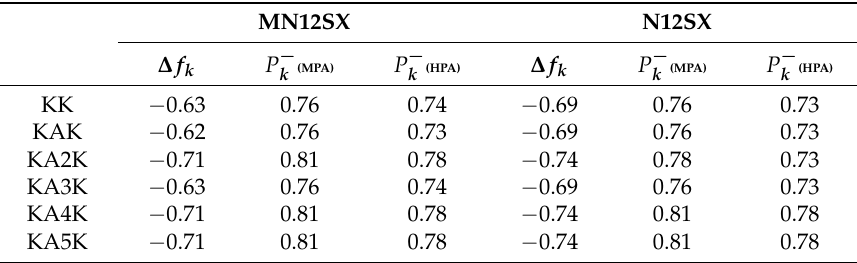
Table 2. Condensed dual descriptors and electrophilic Parr functions P − KA3K, KA4K, and KA5K peptides calculated with the MN12SX and N12SX density functionals and